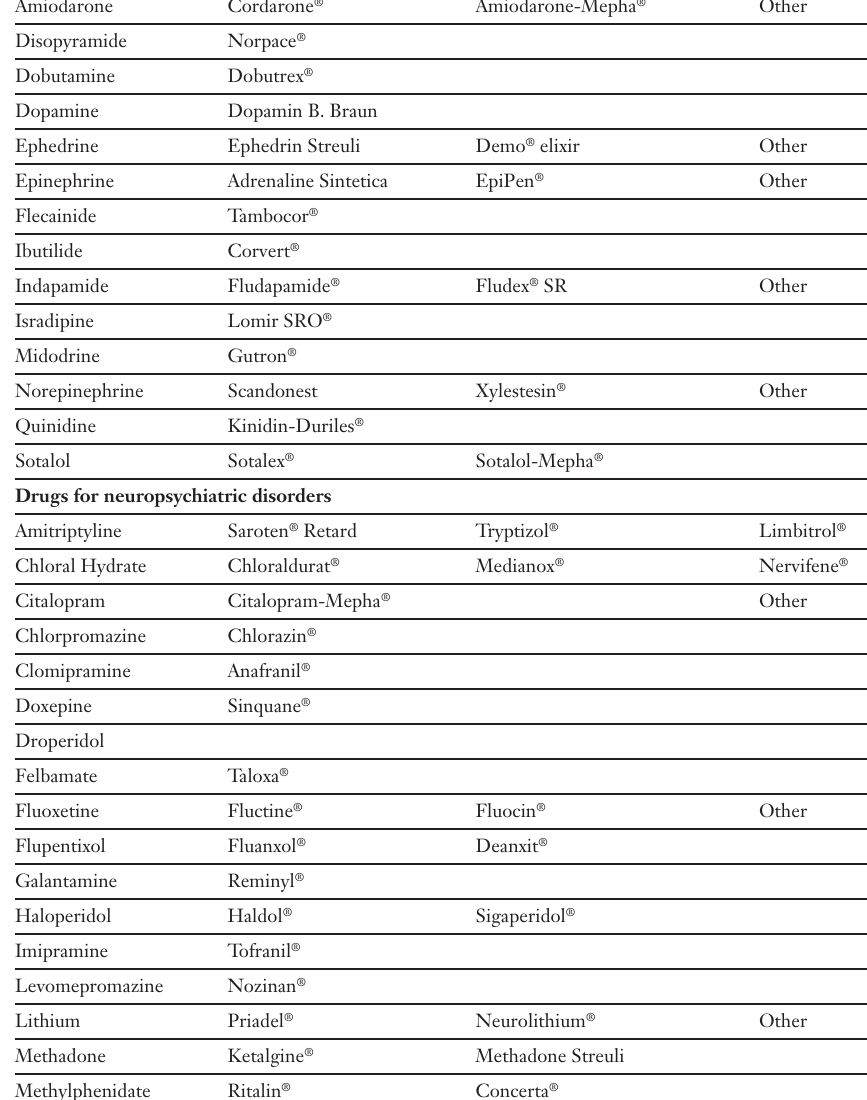
List of drugs found on the Swiss market that can prolong the QT